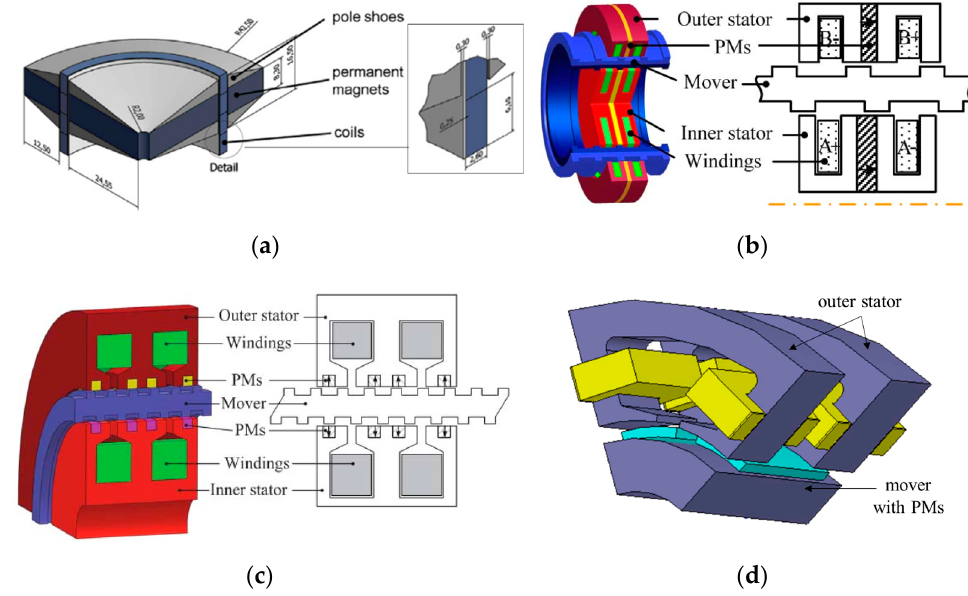
Figure 7. Examples of PM-LOA configurations; ( a ) PM stator with moving coils [30]; ( b ) double U-shaped stators with PM, windings, and VR mover [66]; ( c ) cross section of a double E-shaped stator tubular Vernier PM-LOA [67]; and ( d ) 3D schematic portion of the transverse-flux MM-LOA [69]. Republished with permission of Elsevier and